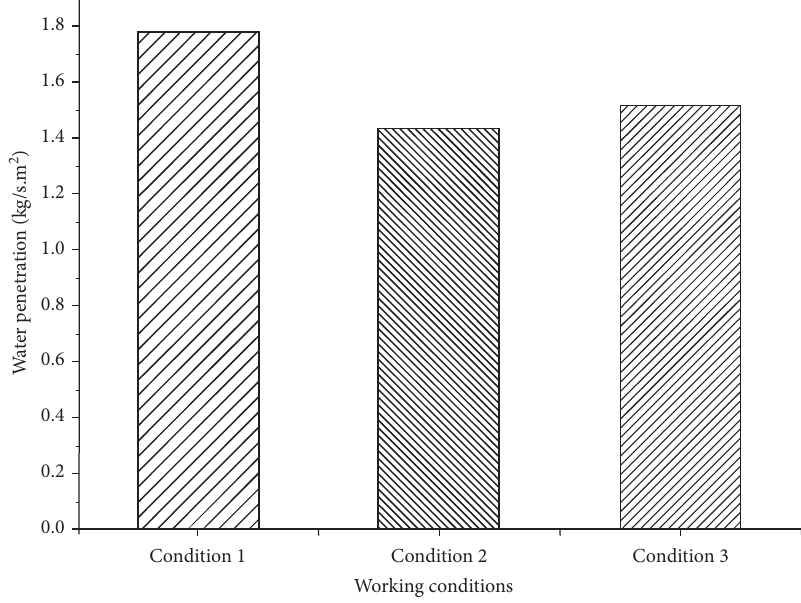
Figure 9: Average water permeability per unit area per unit time under different working